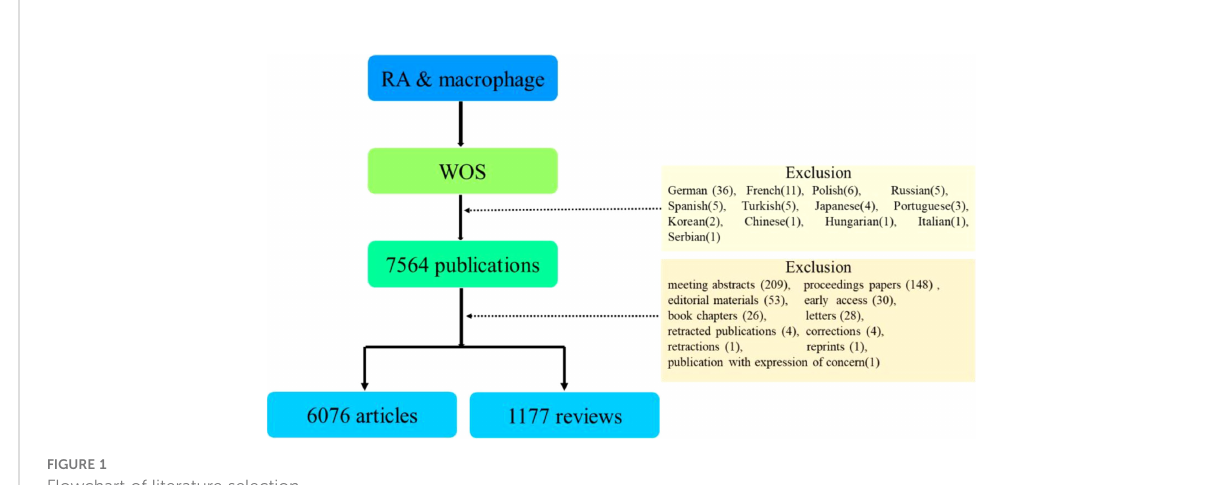
FIGURE 1 Flowchart of literature